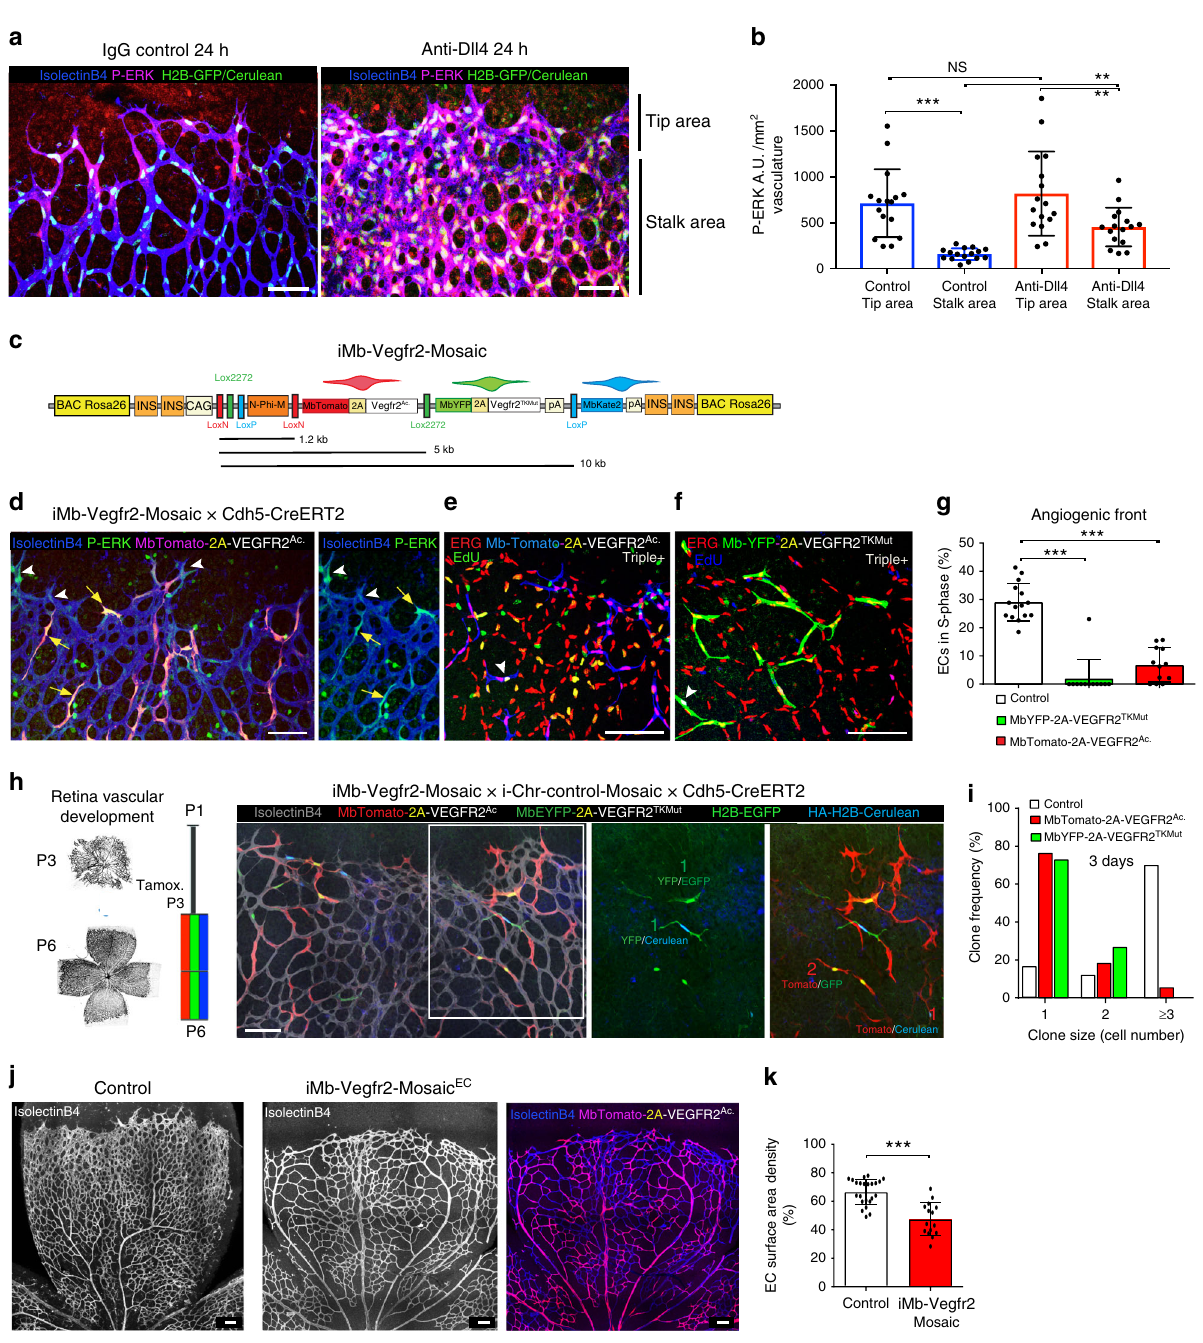
Fig. 3 Angiogenic ECs with high VEGFR2 and ERK signalling exit the cell cycle. a Confocal micrographs of the retinal angiogenic front in iChr-Cerulean/GFP x Tie2-Cre reporter mice (see also Supplementary Fig. 4a), showing labelling of EC nuclei (Cerulean/GFP + ). Activated ERK levels (P-ERK, red) are high in the nuclei and cytoplasm of endothelial tip cells (left image). Dll4/Notch inhibition increases P-ERK levels, particularly in stalk cells. b Quanti fi cation of P-ERK signals in tip and stalk cells from animals 24 h after injection with control IgG or anti-Dll4. Comparison of indicated parameters in large microscopic fi elds of IgG control ( n = 3) or anti-Dll4 ( n = 4) treated mice. c iMb-Vegfr2 Mosaic construct with genetic distances in kilobases (kb). d ECs expressing VEGFR2 Ac (MbTomato + , yellow arrows) have high P-ERK levels, like some endothelial tip cells (white arrowheads). See also Supplementary Fig. 5b. e – g ECs expressing VEGFR2 Ac (MbTomato + ) or VEGFR2 TKMut (MbYFP + ) exit the cell cycle. Only a small fraction of MbTomato + or MbYFP + ECs are in S-phase (Erg + /EdU + -white nuclei), indicated with white arrowheads. Chart shows quanti fi cation of several microscopic fi elds from retinas of different mice ( n = 5). h , i Most single ECs with very high (MbTomato + ) or low (MbYFP + ) VEGFR2 signalling do not divide over a 3 day period. The iChr-Control-Mosaic allele was used to increase single-cell pulse – chase clonal resolution. Chart shows quanti fi cation of several clones in large microscopic fi elds ( n = 4 retinas per group). j , k The increase in VEGFR2 activity in iMb-Vegfr2-Mosaic Cdh5-CreERT2 retinal vessels from P2 to P6 arrests physiological angiogenesis. MbTomato labelling shows the mosaic induction of the transgene in the endothelium (isolectinB4 + ), resulting in a signi fi cant decrease in vascular development. Chart shows quanti fi cation of large microscopic fi elds from several retinas of control ( n = 3) and mutant ( n = 2) mice. Scale bars in all panels, 100 μ m. Error bars indicate std. dev.; NS nonsigni fi cant; *** p < 0.0005; ** p < 0.005. One-way ANOVA with Tukey ’ s post hoc test ( b , g ) or two- tailed unpaired t test ( k ). Source data are provided as a Source Data fi